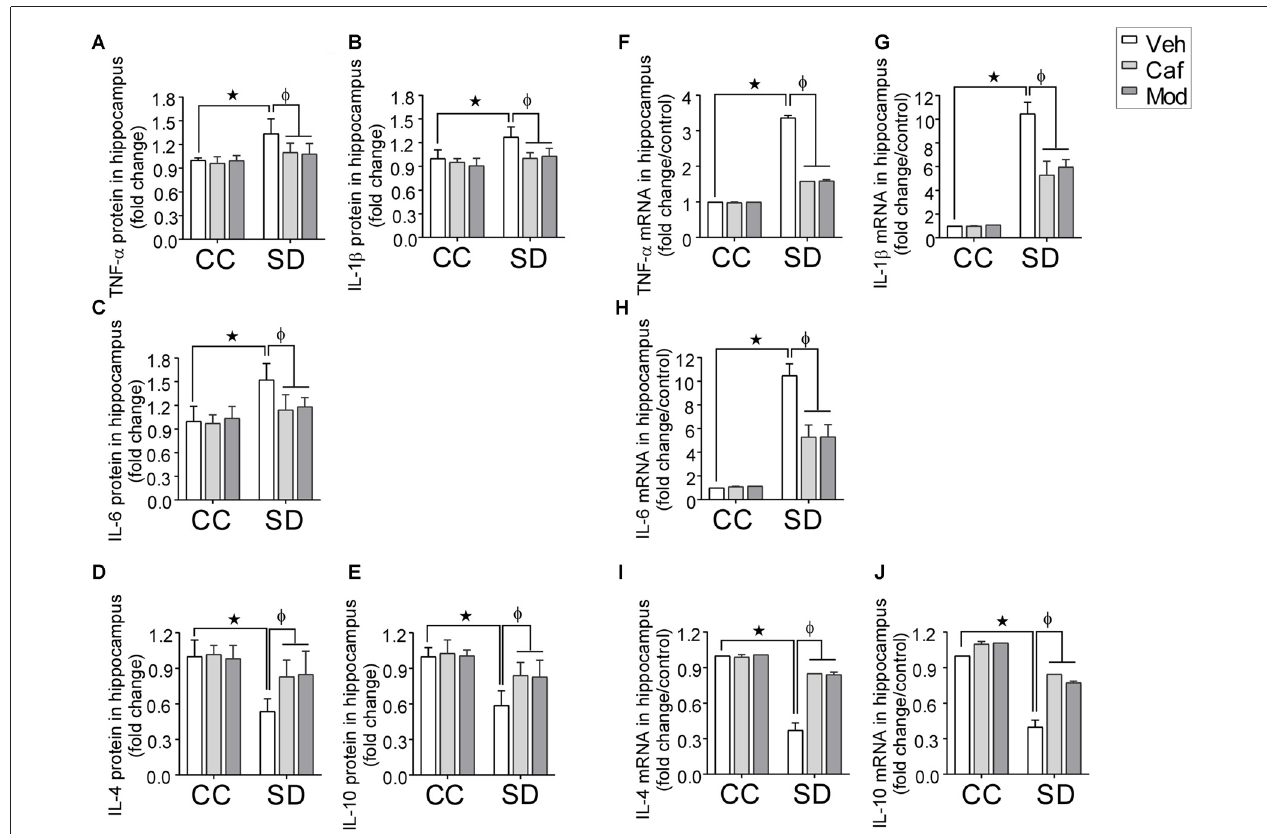
FIGURE 4 | Fold changes in the inflammatory cytokines in hippocampus during caffeine/modafinil administration following SD. The concentration of cytokine levels were measured in picograms per milliliter and expressed as the fold changes in TNF- α (A,F) ; interleukin-1 β (IL-1 β ) (B,G) ; IL-6 (C,H ; pro-inflammatory cytokines), IL-4 (D,I) ; IL-10 (E,J ; anti-inflammatory cytokines) in the hippocampus. ∗ p < 0.05 when compared to control treated with vehicle; φ p < 0.05 when compared to sleep deprived treated with vehicle. Two way ANOVA followed by Tukey post hoc test with multiple comparison were used for the statistical